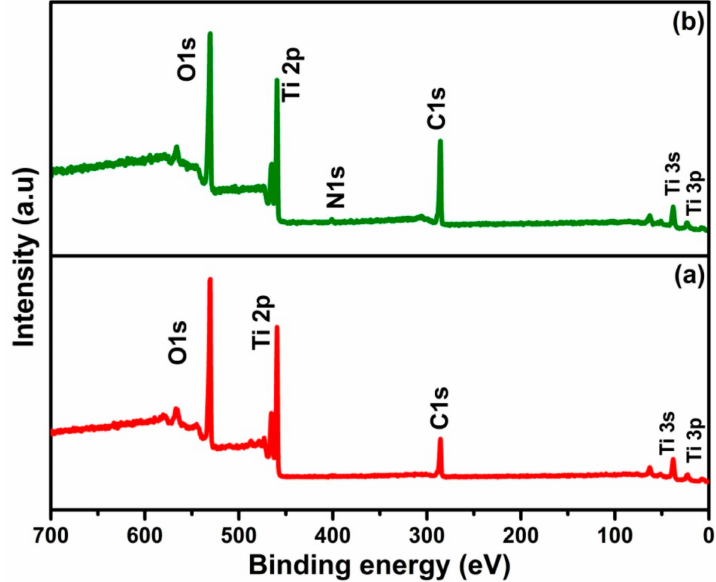
Figure 4. X-ray photoelectron spectroscopy (XPS) survey scan spectra of ( a ) TiO 2 nanotubes and ( b ) N-TiO 2 nanotubes.